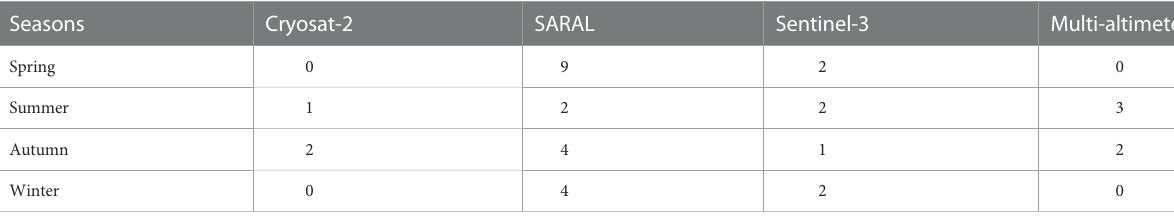
the improvement of coastal waveforms from different altimeters by ALES+ retracker. The water level accuracy after retracking coastal waveforms with multiple retrackers and single retracker (Table 6) identi fi ed that the overall retracking performance of the Sentinel-3 altimeter was better than the SARAL altimeter when only used ALES+ retracker. Due to the small study area of this paper and the small number of quasi-specular waveforms and complex waveforms, the water level accuracy after retracking coastal waveforms with multiple retrackers and single retracker did not show signi fi cant differences. In addition to the retracking method, the operation mode of the altimeter is also an important factor affecting the water level accuracy in coastal areas. The water level accuracy of the three altimeters (Figure 6) revealed that the water level accuracy of the TABLE 7 The mutation times of the time-series water levels in different seasons. Seasons Cryosat-2 SARAL Sentinel-3 Multi-altimeter